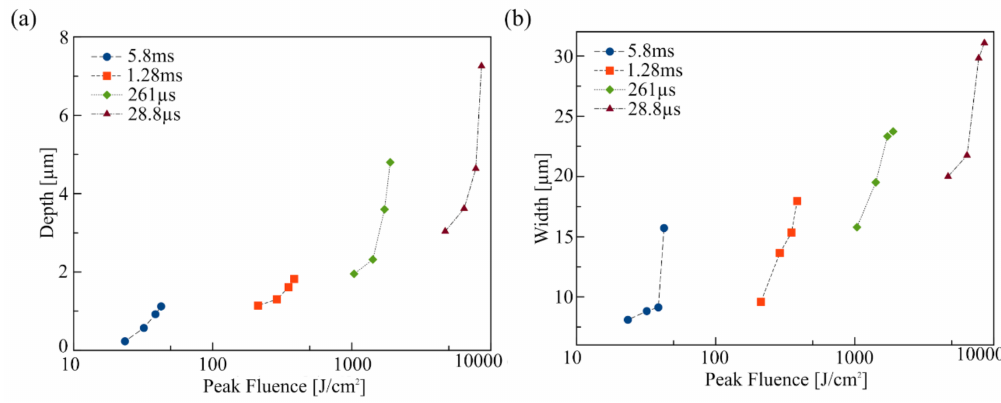
Figure 2. Laser-etching control in PMMA substrates: average depth ( a ) and width ( b ) as a function of laser power density and pulse time. Data points are averaged over the full